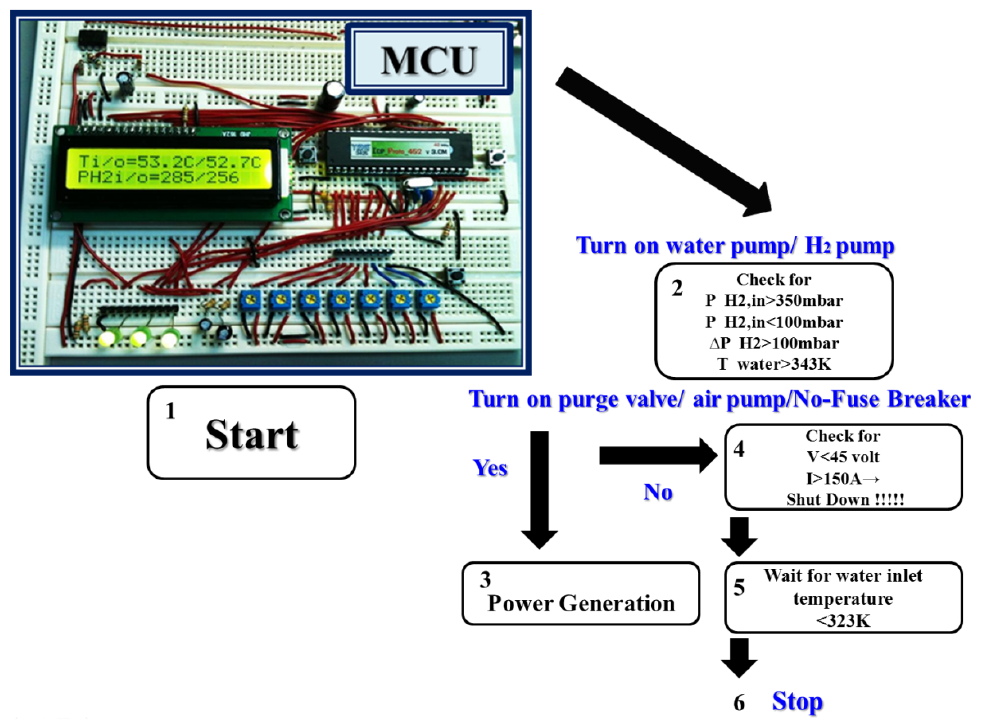
Figure 1. The microcontroller units (MCU) control